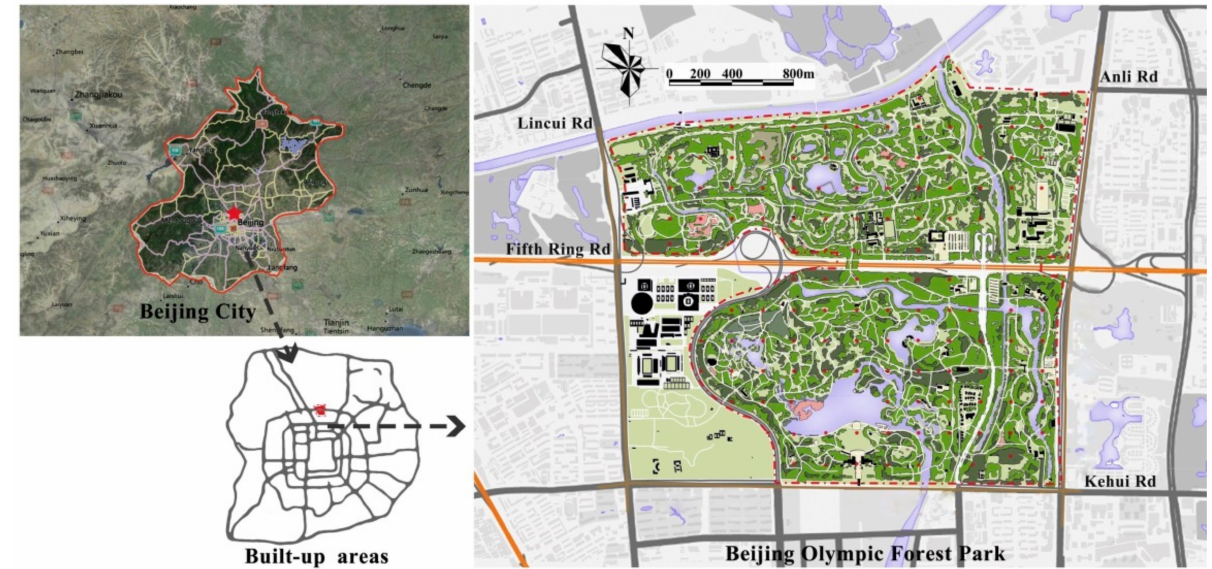
Figure 1. The geographic location of the study area (reproduced with authorization from Professor DONG Li’s research team from School of Landscape Architecture, Beijing Forestry University).